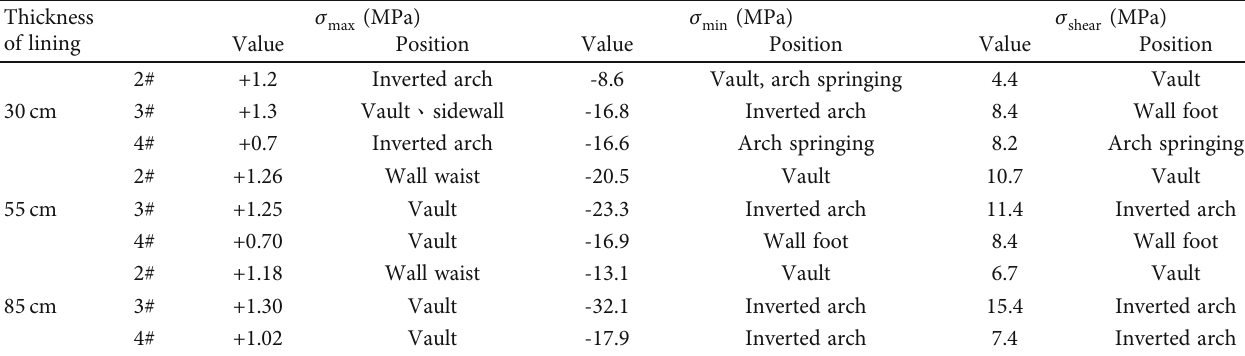
Table 4: Comparison of segment stress under three di ff erent lining